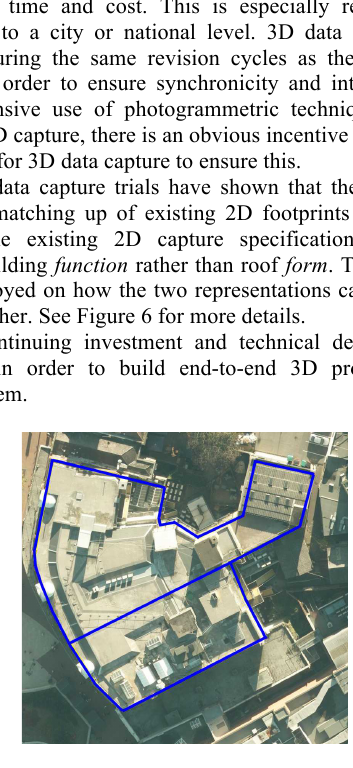
Fig 6. The 3D roof level structures clearly do not match with the 2D